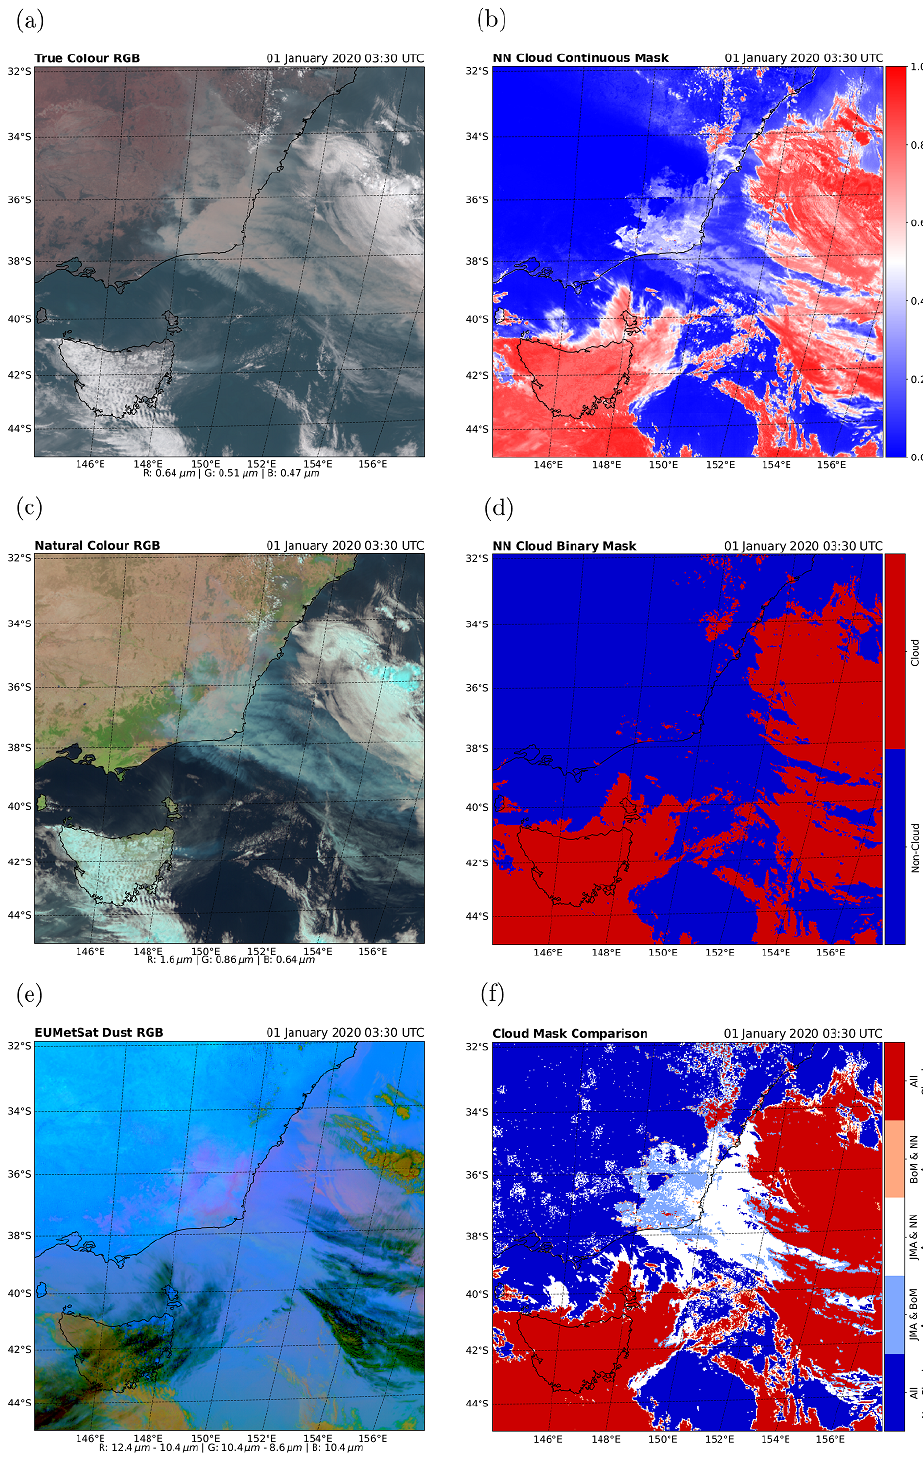
Figure 10. Region A on the SE coast of Australia from an AHI scene for 1 January 2020 at 03:30UTC. A total of three RGB false-colour composites of the scene are presented in the left-hand column, showing (a) true-colour, (c) natural-colour and (e) dust RGBs. The top, middle and bottom panels of the right-hand column show (b) the NN continuous cloud mask, (d) NN binary cloud mask and (f) a comparison of the three binary masks for the